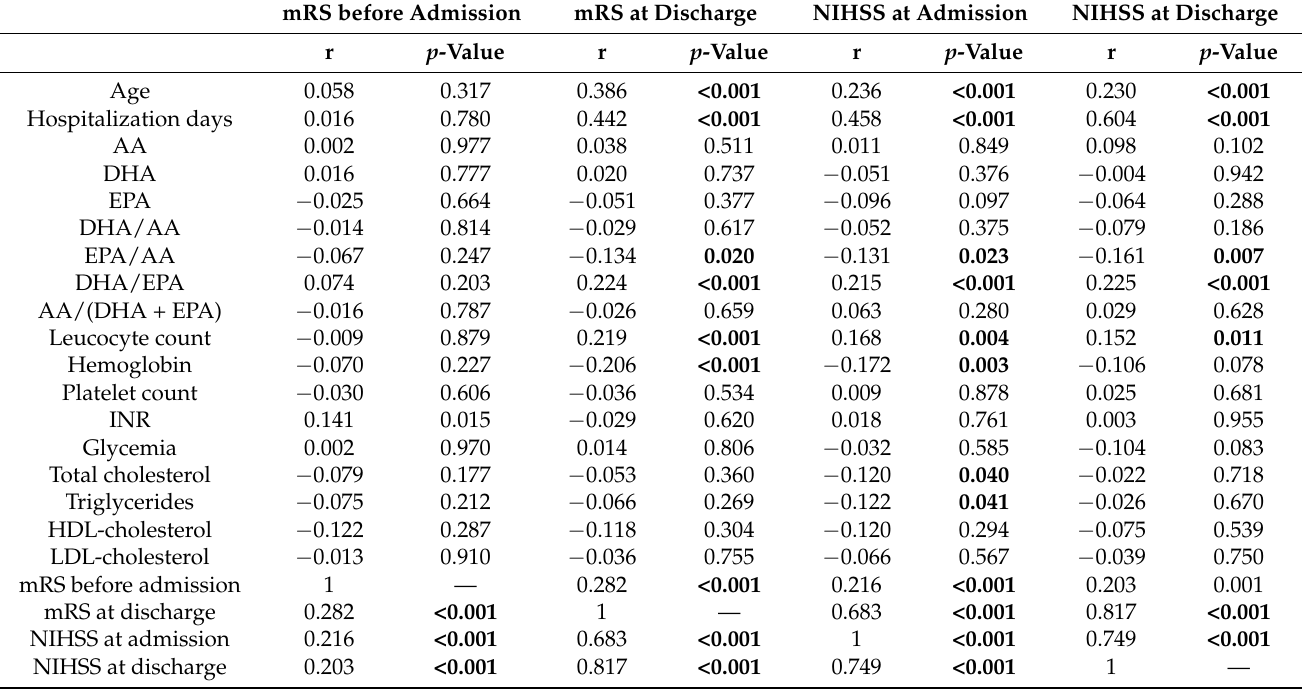
Table 7. Pearson correlations of all parameters and prognostic